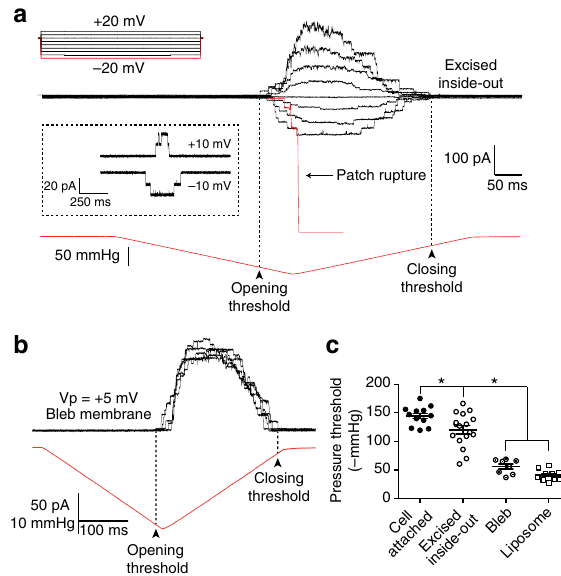
Figure 3 | Activation of MscL–GFP in bleb-attached patches clearly illustrates the different mechanical environments. ( a ) A family of MscL current activity in an excised inside-out patch in response to pressure ramps (300s to peak) at voltages ranging from þ 20 to (cid:2) 20mV. (Inset shows single channel activity elicited by manual pressure application at two opposing voltages). In symmetrical NaCl, 145mM MscL gives a conductance of 1.57nS in excised patches. The conductance is somewhat lower than in previous reports owing to a reduction in the bulk conductivity of this recording solution in comparison with the widely used KCl 200mM and MgCl 2 40mM buffer. ( b ) Illustration of MscL activity in membrane blebs; traces show six sweeps of identical pressures. ( c ) Pressure thresholds of activation for WT MscL in four configurations; cell-attached, excised, bleb-attached and excised azolectin liposome (data points represent individual experiments with mean ± s.e.m. shown for comparison). Pressure thresholds in cell-attached and excised were some three times higher than those seen in bleb-attached patches (* P value o 0.01; one-way analysis of variance, Tukey’s post hoc test).